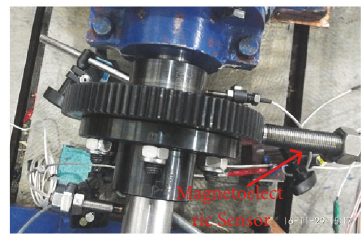
Figure 14: Photo of torsional measuring